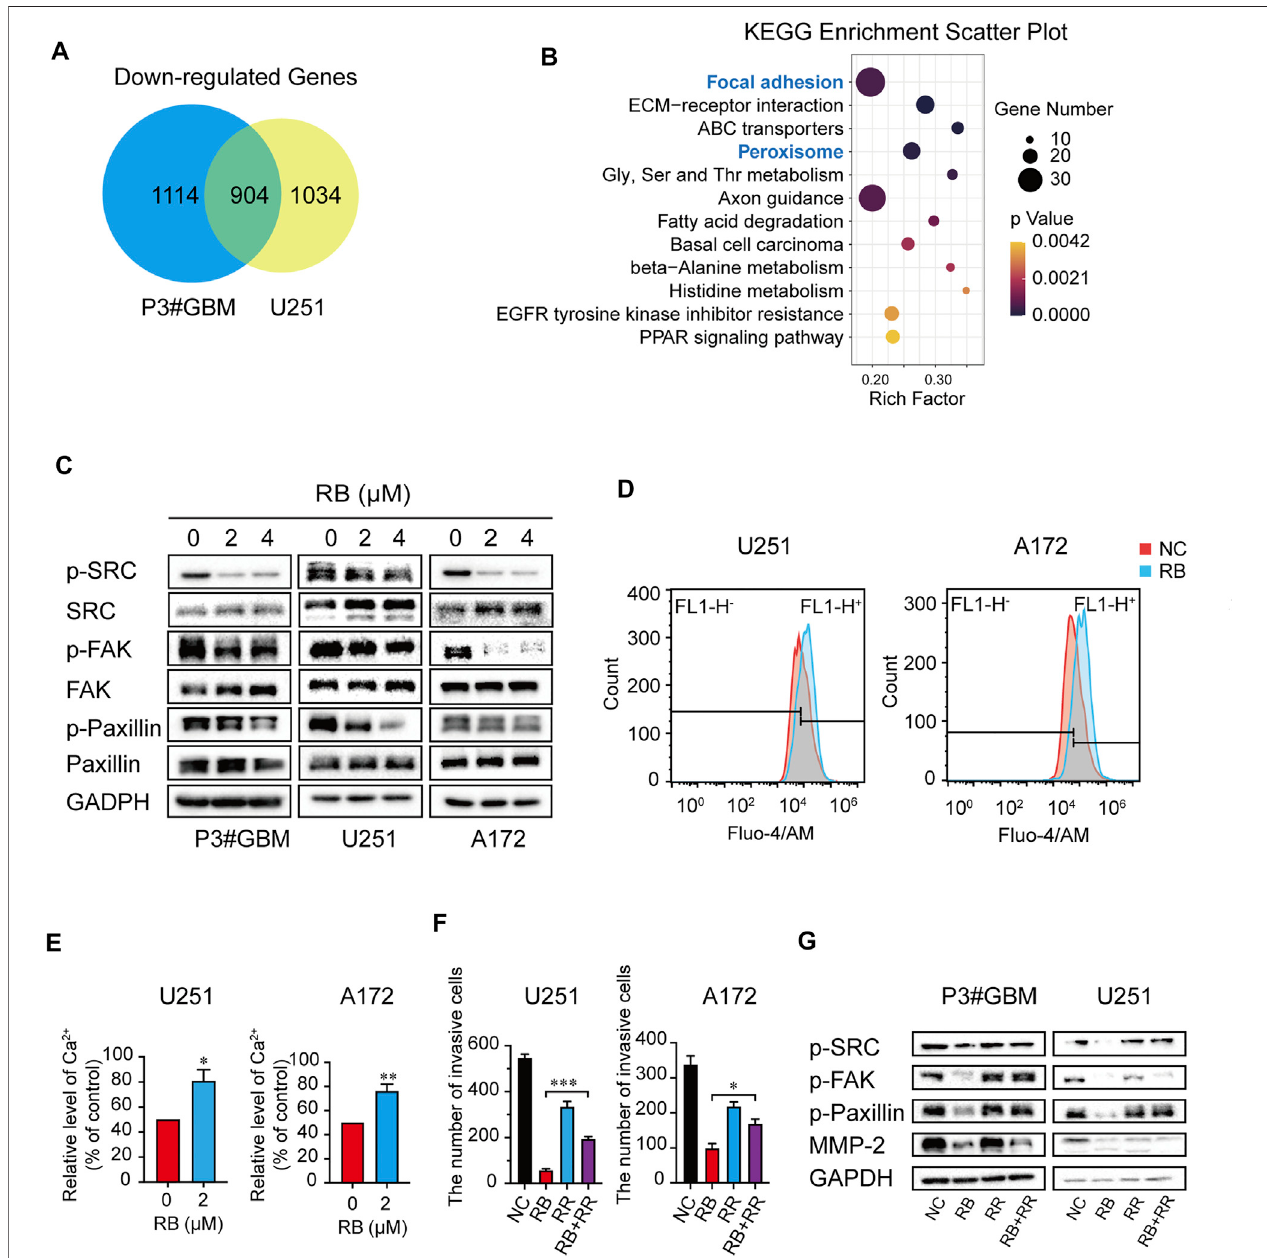
FIGURE4| RBinhibitsGBMcellinvasionpartiallybyelevatingintracellularCa 2+ levelstosuppresstheSrc/FAK/Paxillinfocaladhesionpathway. (A) Intersectionsof genes with downregulated expression in P3#GBM and U251 cells treated with 4 μ M RB compared with control cells. (B) KEGG pathway enrichment analysis of intersecting genes with downregulated expression. (C) P3#GBM, U251 and A172 glioma cells were treated with RB for 48 h. Western blot analysis was used to determine focal adhesion-associated protein expression levels. (D) Intracellular Ca 2+ wasmeasured by Fluo-4/AM with fl ow cytometry. (E) Graphicrepresentation of the mean fl uorescence intensity of Fluo-4/AM shown in (D) . (F) The numbers of invasive GBM cells were shown in Supplementary Figure S2G . (G) Western blot analysis showed that blocking Ca 2+ withRR treatment for 48 h rescued RB-induced inhibition ofinvasion in U251 and A172 cells. Three independent experiments were performed with data shown as the mean ± SEM by unpaired Student ’ s t test (E) or one-way ANOVA (F) . * p < 0.05; ** p < 0.01 and *** p < 0.001.